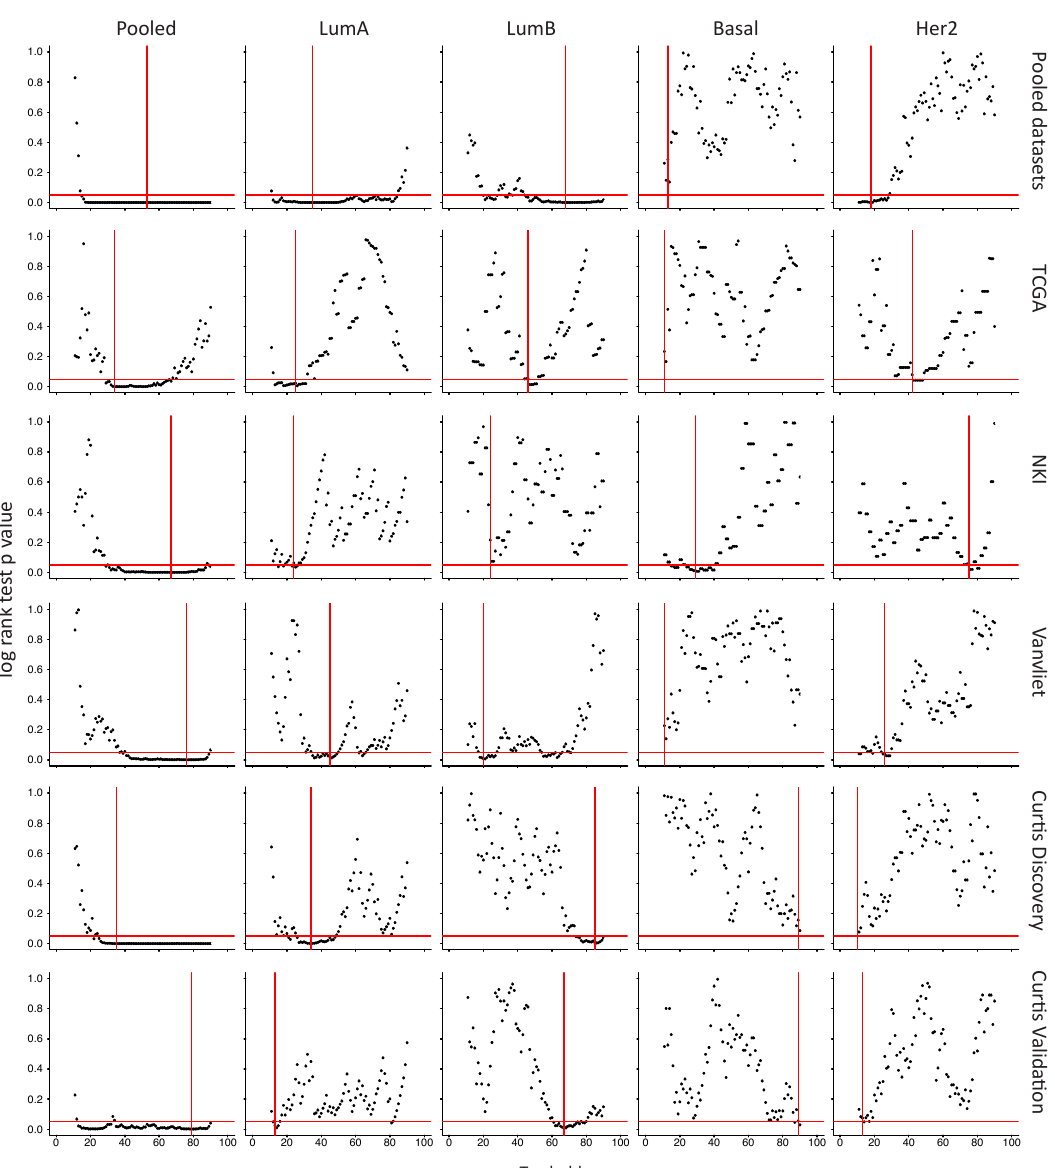
Figure A10. Determination of the best cutoff for GJA1 using the log rank test p value in individual subtypes of breast cancer. Graph of the p value of the log rank test to compare the survival of patients with Cx43 expressed at high or low levels according to varying thresholds (10–90 percentile). Horizontal red lines indicate 0.05 p value. Vertical red lines indicate the threshold with the lowest p value for the log rank test, used for subsequent survival analysis in Figures 7 and A12. Results given for pooled tumors or individual breast cancer subtypes in our five datasets (TCGA, NKI, Vanvliet and Curtis discovery and Curtis validation) as well as in aggregated datasets (Pooled